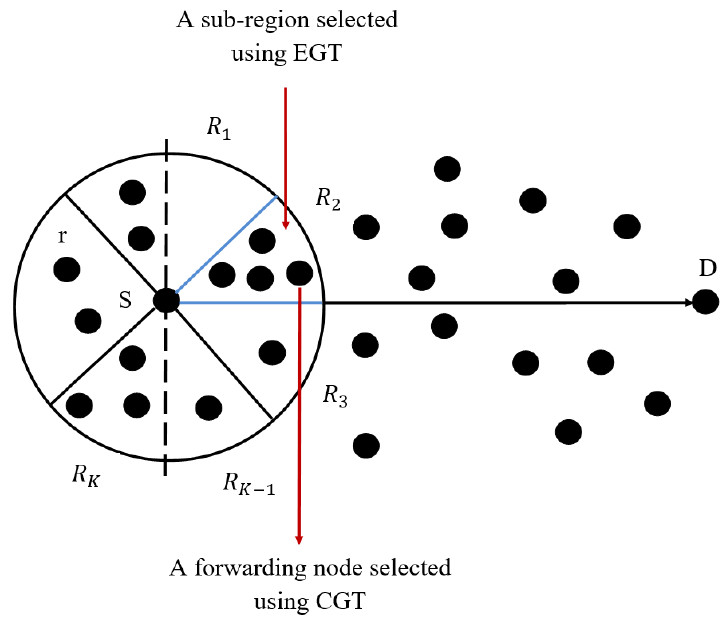
Figure 6. Subregion and node selection.